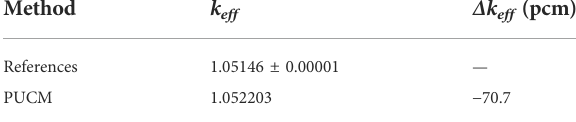
TABLE 2 k eff for the plate cell.